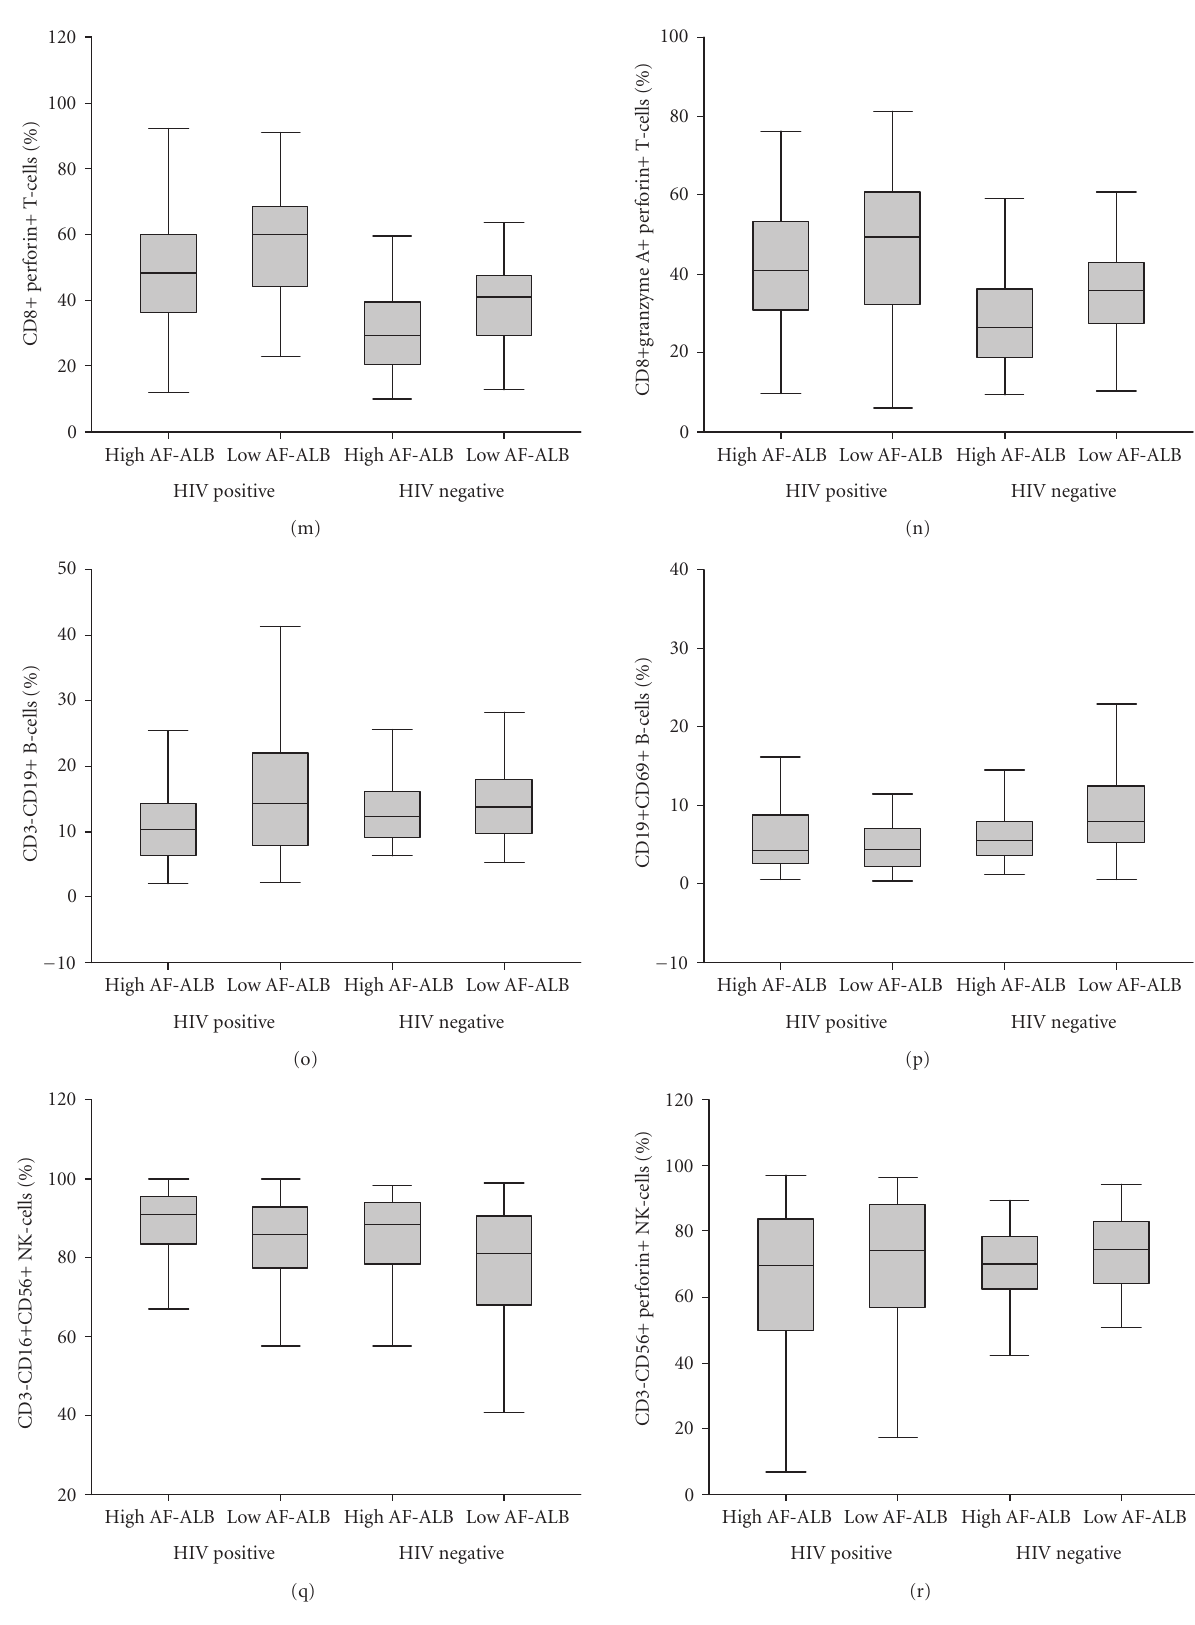
Figure 1: Percentages of T-, B-, and NK-cells in PBMCs in relation to aflatoxin B1 albumin adduct (AF-ALB) levels and HIV infection. The percentages are shown for HIV positive high AF-ALB ( n = 58) and low AF-ALB ( n = 58) groups, and HIV negative high AF-ALB ( n = 40) and low AF-ALB ( n = 40)